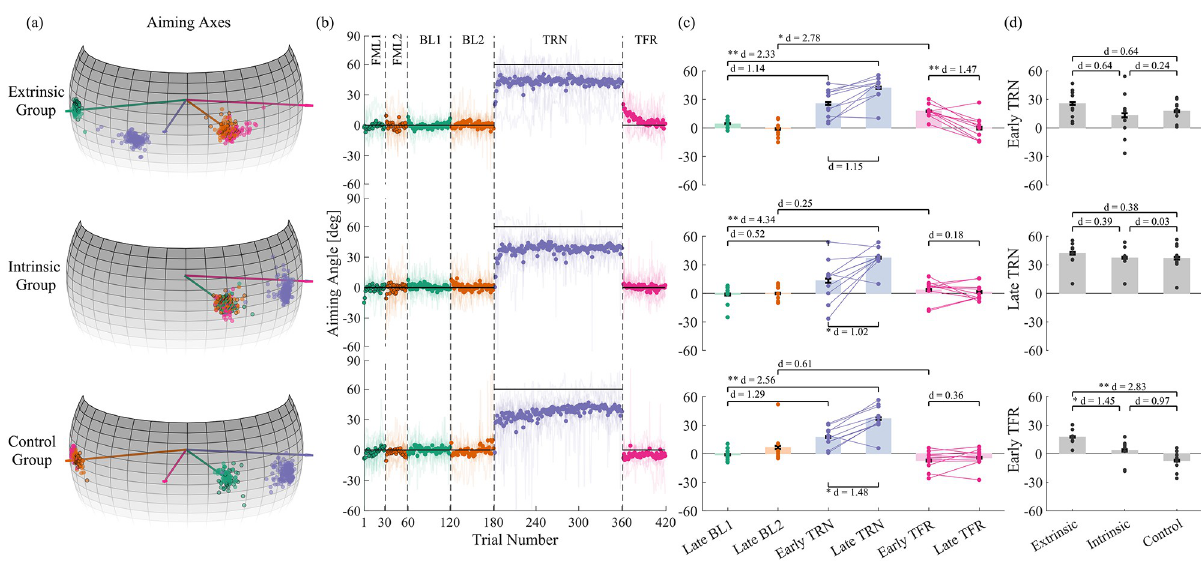
Fig 11. Average aiming axes and angles of all groups in experiment 2 and comparisons of the aiming angles between and within groups. The average aiming axes and angles are consistent with a representation of the partially learned perturbation in extrinsic coordinates and with a narrow generalization to different targets. The colors are as in Fig 3. (a) The course of the aiming axes (dots) averaged over participants in each group, and the ideal axis (arrows) in each session. (b) The time course of the aiming angles (dots) averaged over participants and the standard error (dark shading) of the aiming angles in each group. The light curves show the time courses of the aiming angles of each participant. The dashed lines separate between the different sets of trials. (c) Within groups comparisons of the three-trials averaged aiming angles of all participants (dots) in each of the key stages. The bars and error bars are the mean ± standard error. � p < 0.05, �� p < 0.001. The effect sizes are in the inset. (d) Between groups comparisons of the three- trials averaged aiming angles of all participants in the early TRN stage, the late TRN stage, and the early TFR